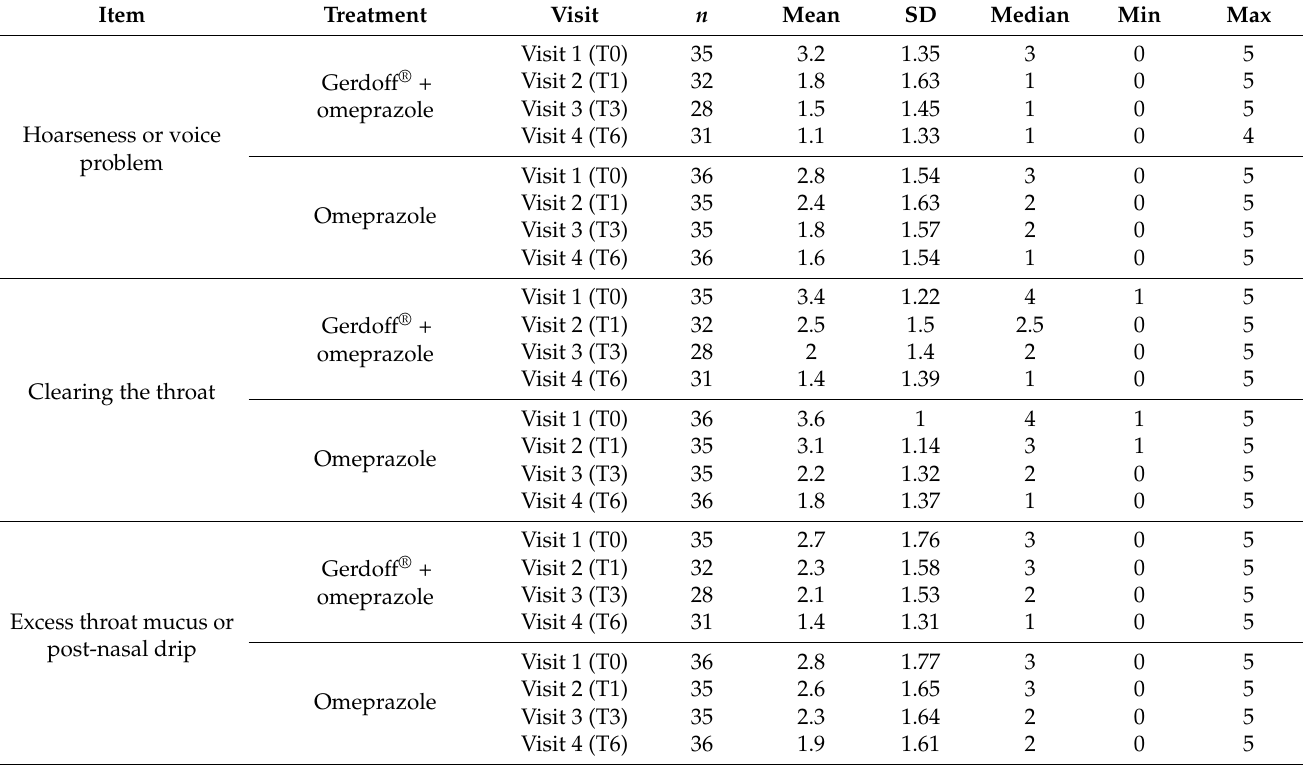
Table 6. Summary of results regarding the changes in individual RSI item scores between baseline and any time point during the 6-week treatment